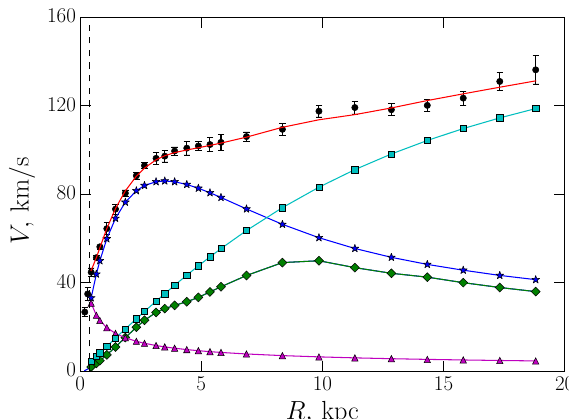
Fig. 1. Circular speed versus radius for the galaxy M33. The black dots with error bars indicate the observed rotation curve (Corbelli & Salucci 2007). The red line is the best-fitting model rotation curve (see the text for the model description). Individual contributions from the components are also shown: pseudo-isothermal DM halo (cyan squares), exponential stellar disk (blue stars), gaseous disk (green diamonds) and stellar nucleus (magenta